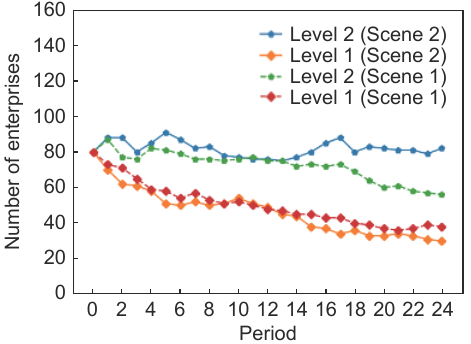
Fig. 4 Scenes 1 and 2: Changes of number of enterprises in Levels 1 and 2.